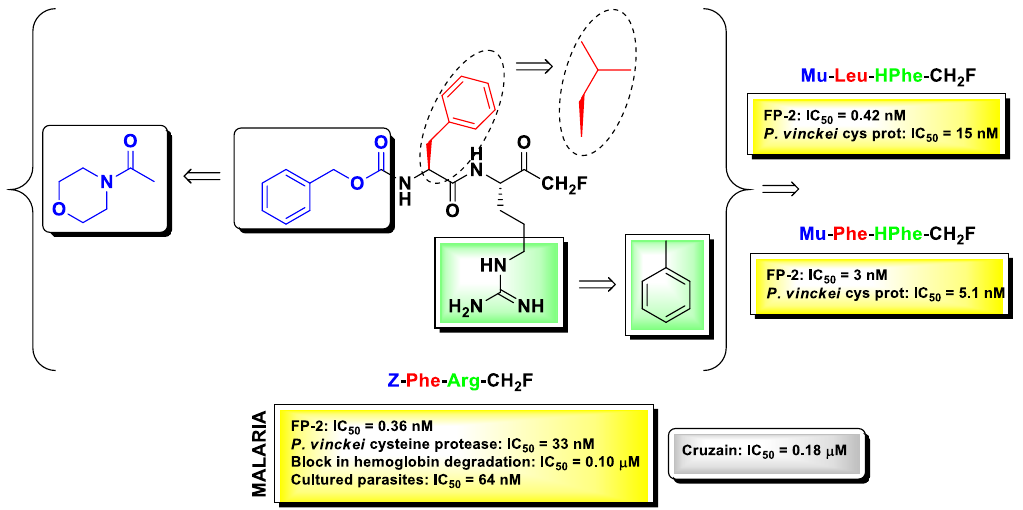
Figure 8. Chemical structure of the most relevant m-PFMK as protozoan cysteine protease inhibitor (Z-Phe-Arg-CH 2 F), together with biological activity and chemical modifications in relation to its antimalarial activity.